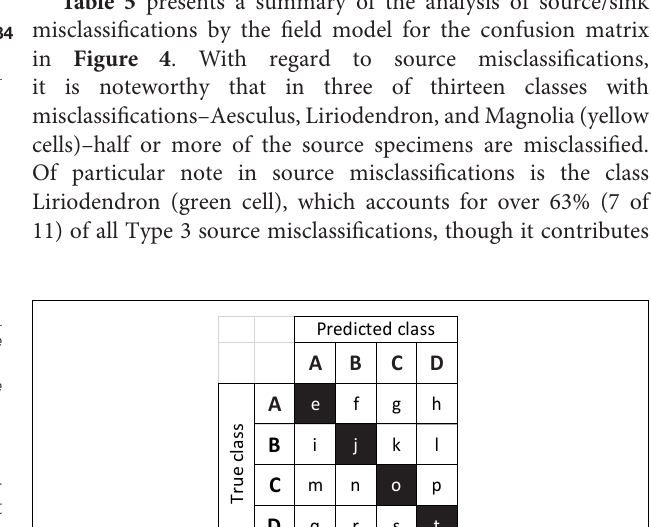
Frontiers in Plant Science |